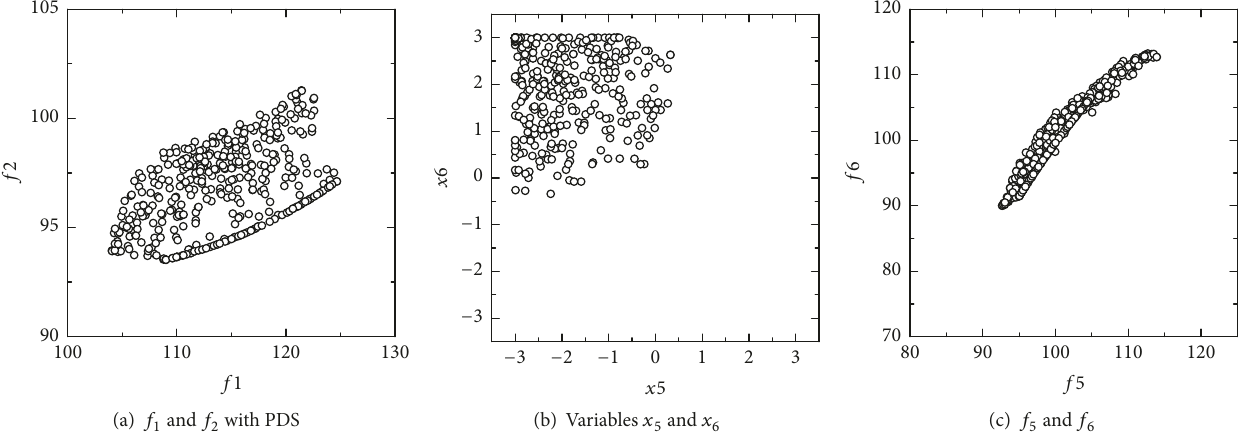
Figure 14: Results by the proposed two-population concurrent evolution method on real world problem, f (𝑚=2) = (𝑓 1 , 𝑓 2 ) , f (𝑀=6) = (𝑓 ,𝑓 , 𝑓 , 𝑓 ,𝑓 , 𝑓 ) , 𝑑 = 5 1 2 3 4 5 6